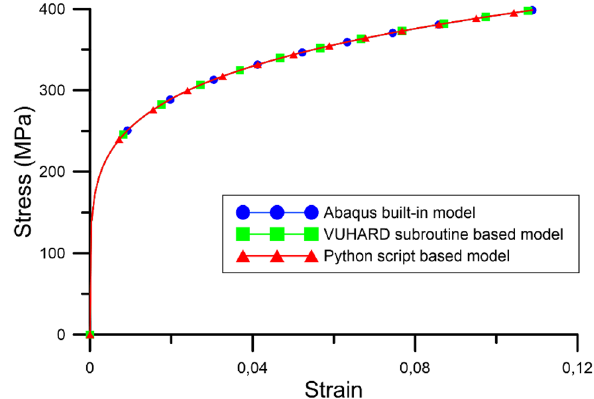
Fig. 9 Comparison of homogenized flow stress curves obtained from three tested JC model variants